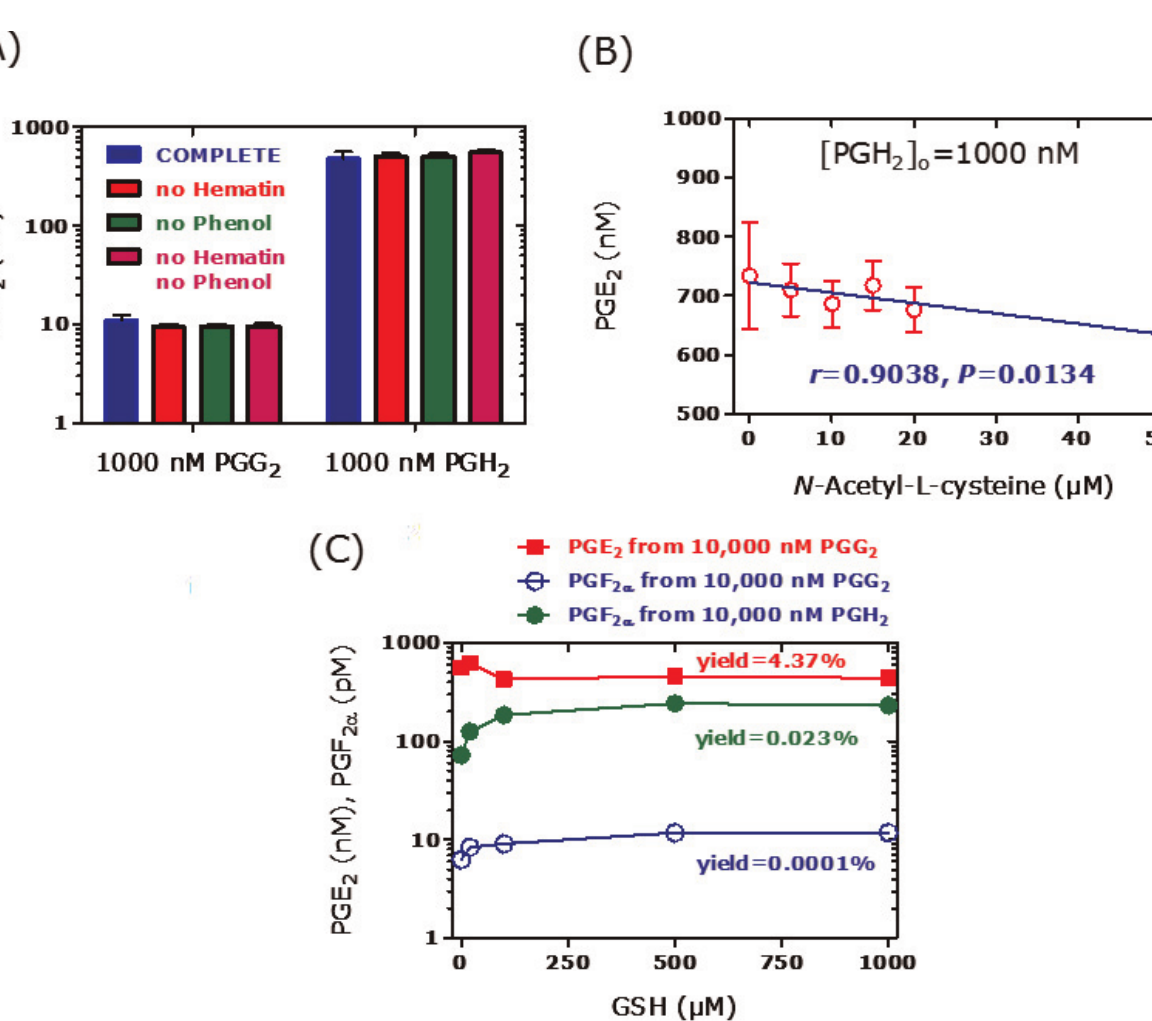
Figure 2. Formation of PGE 2 and PGF 2 α from synthetic PGG 2 and PGH 2 in buffer at 37°C after incubation for 10 min. (a) Each 1000 nM of PGG 2 and PGH 2 were incubated in complete buffer (2 mM phenol, 1 µM hematin), as well as in the absence of phenol, of hematin or of both. (b) Effect of various concentrations of N -acetyl-L-cysteine (0 – 50 µM) on the formation of PGE 2 from synthetic PGH 2 used at a nominal concentration of 1000 nM in complete buffer. (c) Effect of reduced glutathione (GSH) used at various concentrations (0 – 1000 µM) on the formation of PGE 2 from synthetic PGG 2 and PGH 2 used at a nominal concentration of 10,000 nM each in complete buffer. Experimental conditions and prostanoids analysis were as described elsewhere (3). Data are shown as mean and standard deviation of two independent